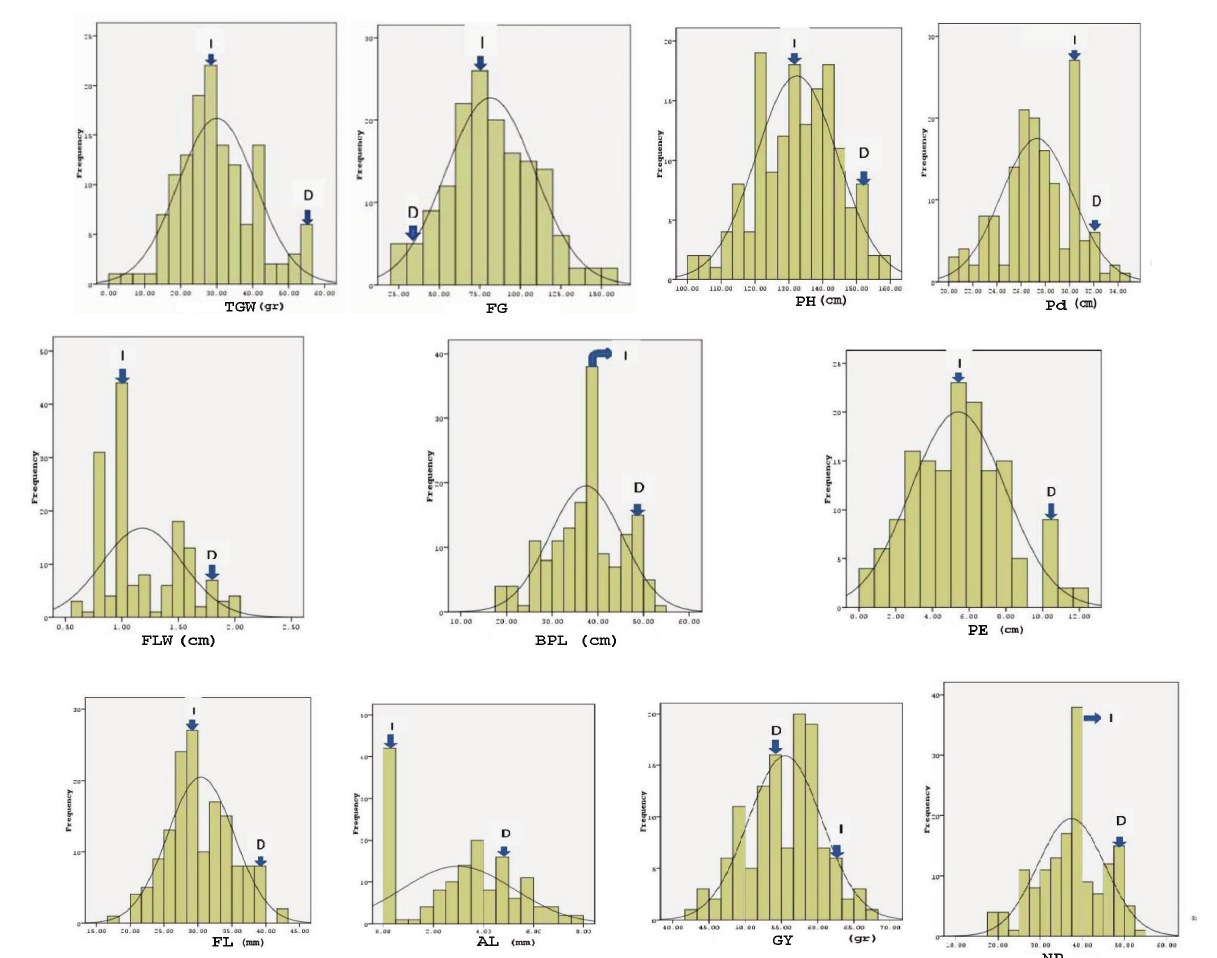
Fig. 1. Frequency distribution of the means of the 160 F cated by